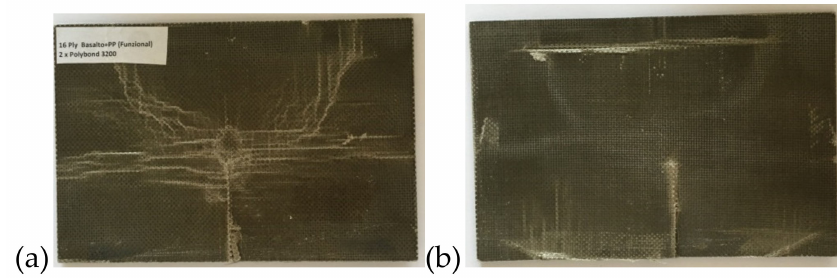
Figure 6. Impacted PP basalt samples at penetration: ( a ) Front; ( b ) back.